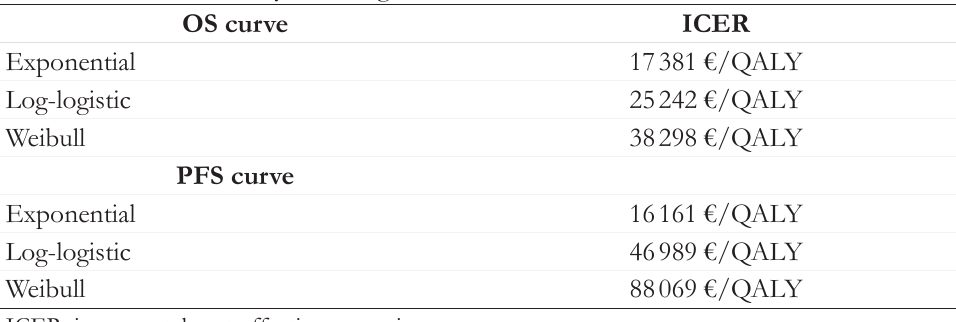
Table 6. Scenario Analysis Using Different Fitted Survival Curves OS